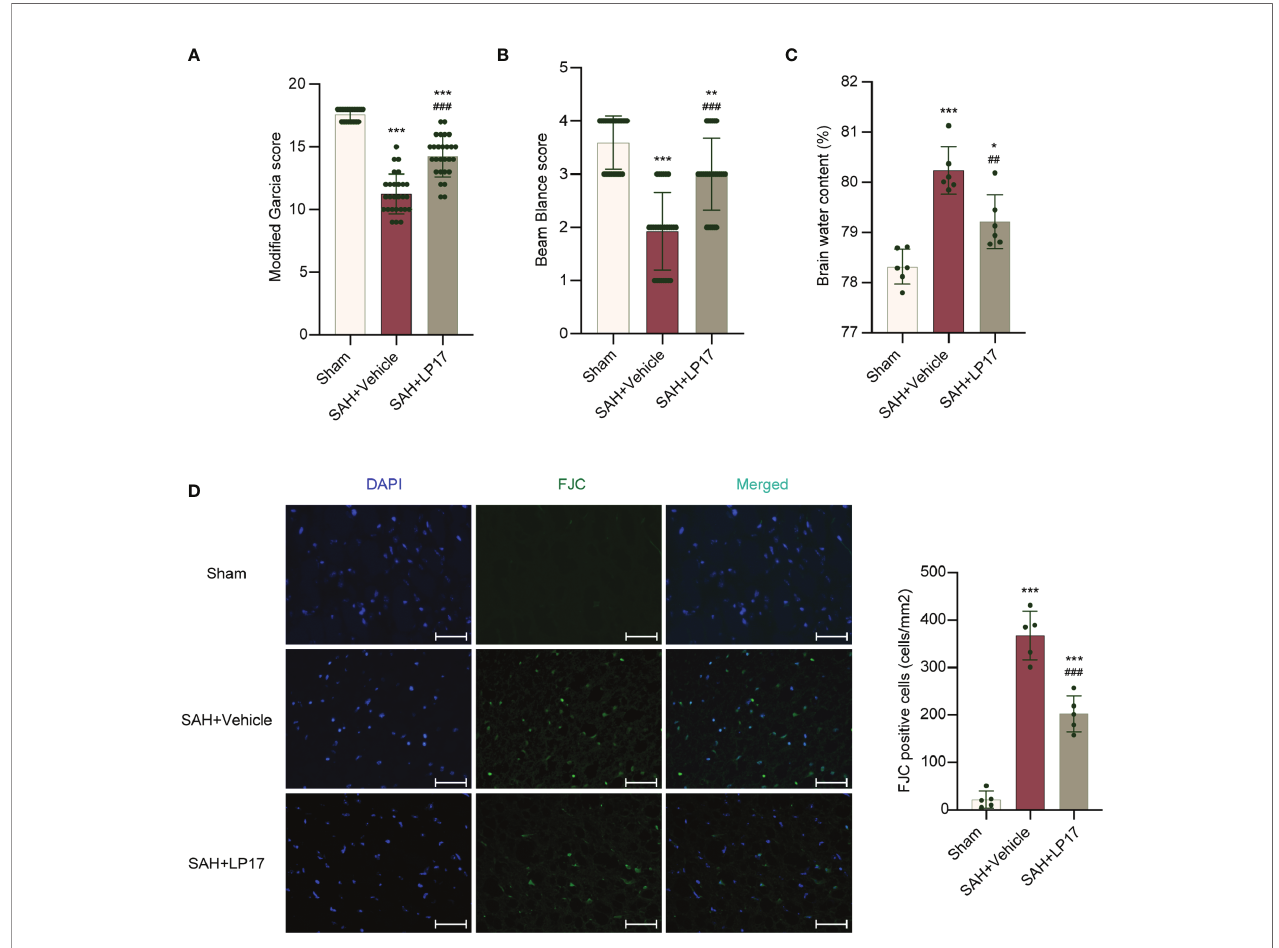
FIGURE 3 | LP17 treatment improved neurological performance, attenuated brain water content, and neuron damage. (A, B) Quanti fi cation of neurological function. (modi fi ed Garcia score and beam balance test) at 24 h after SAH. n = 27/group. (C) Quanti fi cation of brain water content. n = 6/group. (D) Representative photograph and quantitative analysis showed the FJC positive cell (green) in different groups. n = 5/group. Data are expressed as mean ± SD. *P < 0.05, **P < 0.01, ***P < 0.001 vs Sham group; ## P < 0.01, ### P < 0.001 vs SAH+vehicle group. Scale bar = 50 m